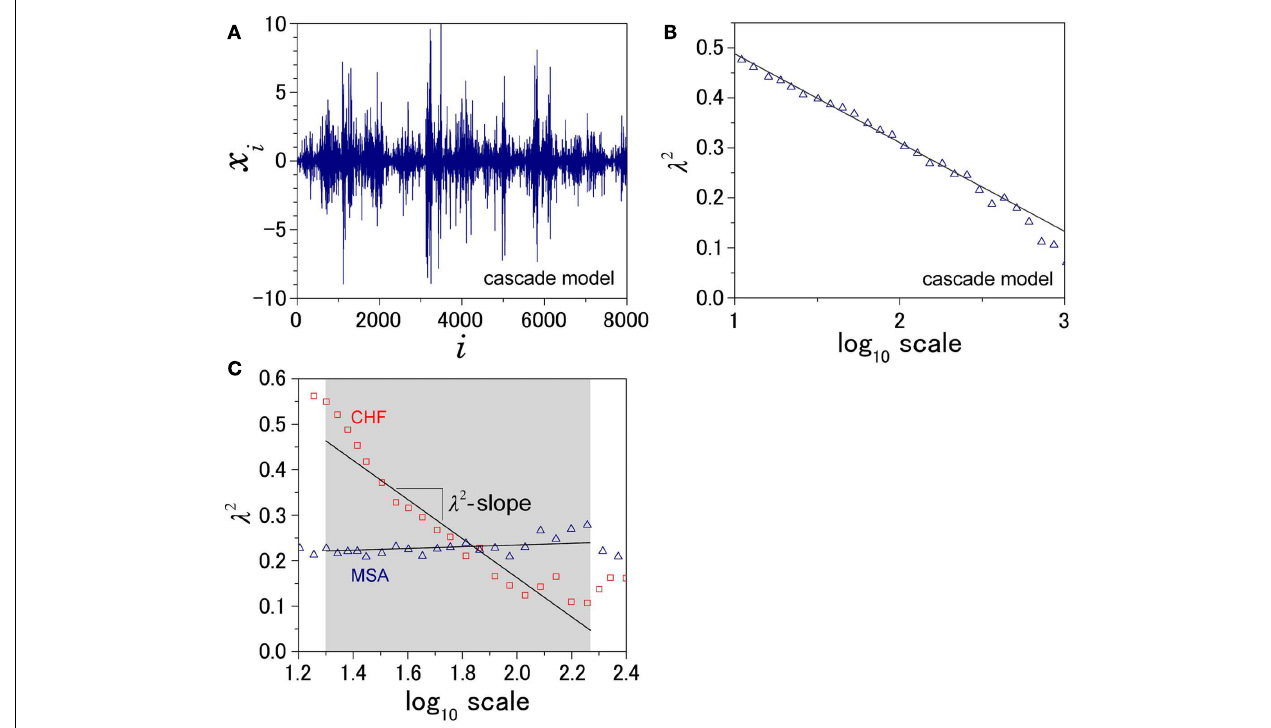
FIGURE 1 | Illustration of the definition of λ 2 -slope. (A) An example of intermittent fluctuation generated by a cascade model (Kiyono et al., 2007) and (B) the scale dependence of λ 2 , which is proportional to the logarithmic scale.To quantify this kind of intermittent behavior of HRV, λ 2 -slope is defined